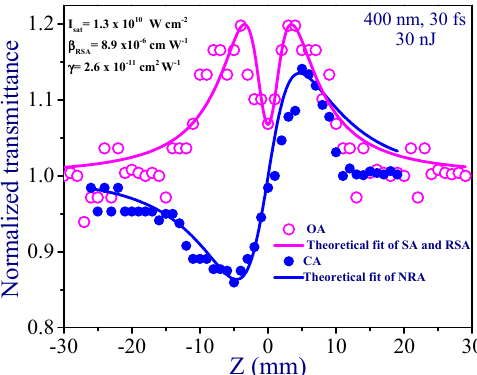
Figure 3. Open aperture (OA) and closed aperture (CA) Z-scan curves of thin film measured using the 400 nm, 30 fs pulses. SA is saturable absorption; RSA is reverse saturable absorption; NRA is nonlinear refraction and absorption.